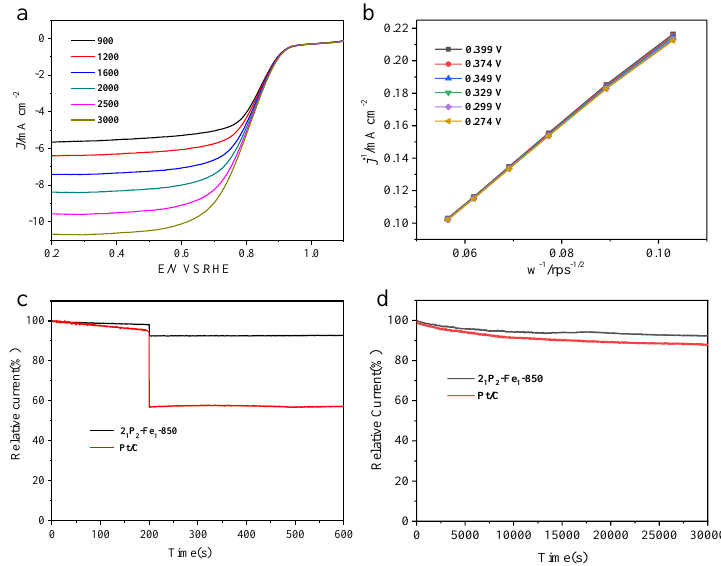
Figure 2. ( a ) Polarization curves of 2 1 P 2 -Fe 1 -850 at different rotational speeds; ( b ) K–L plots of 2 1 P 2 - Fe 1 -850; ( c , d ) 30,000 s durability curves of 2 1 P 2 -Fe 1 -850 and Pt/C and methanol tolerance curves.